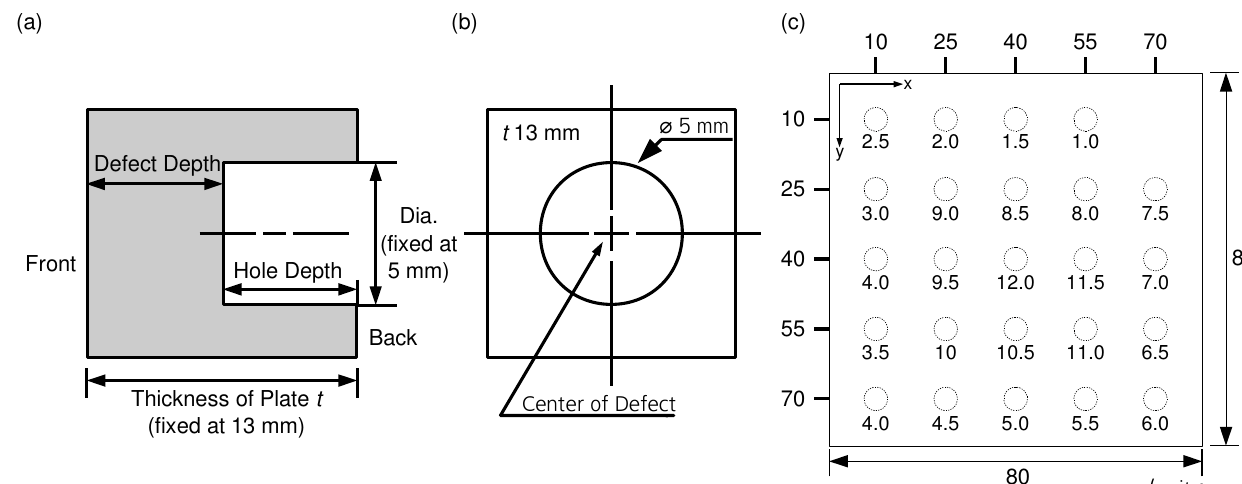
Figure 4. Design and distribution of artificial defects and nomenclature of the parts. ( a ) Cross-section of a defect, ( b ) structure of the backside, and ( c ) front side of a specimen and defect